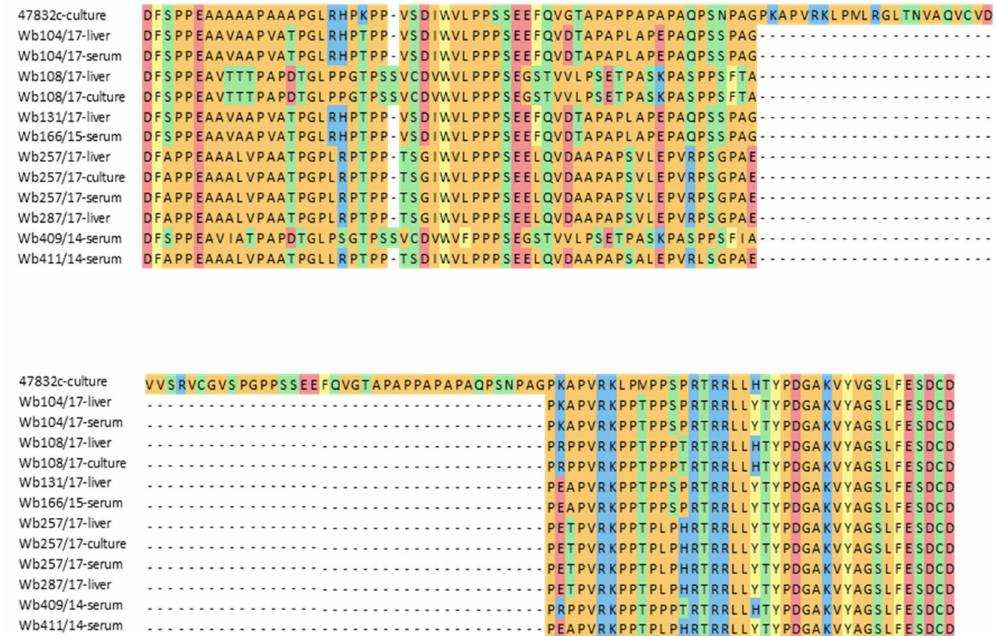
Figure 3. Alignment of amino acid sequences deduced from RT-PCR products of the hypervariable region (HVR) of the HEV genome. Sequences of the cell culture-adapted control strain 47832c containing a well-known insertion within the HVR (47832c-culture), wild boar serum and liver samples used for the cell culture isolation experiment (indicated as serum or liver), and cell culture-isolated HEV strains from samples Wb108/17 and Wb257/17 at 49 d p.i. of 2nd passage (indicated as culture) are